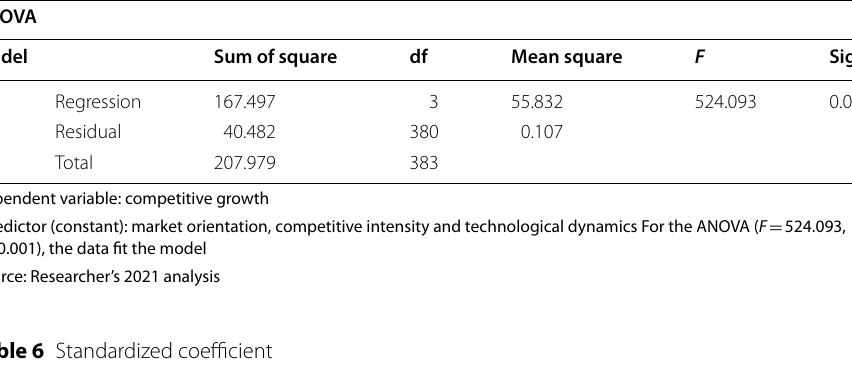
Table 5 Analysis of variance